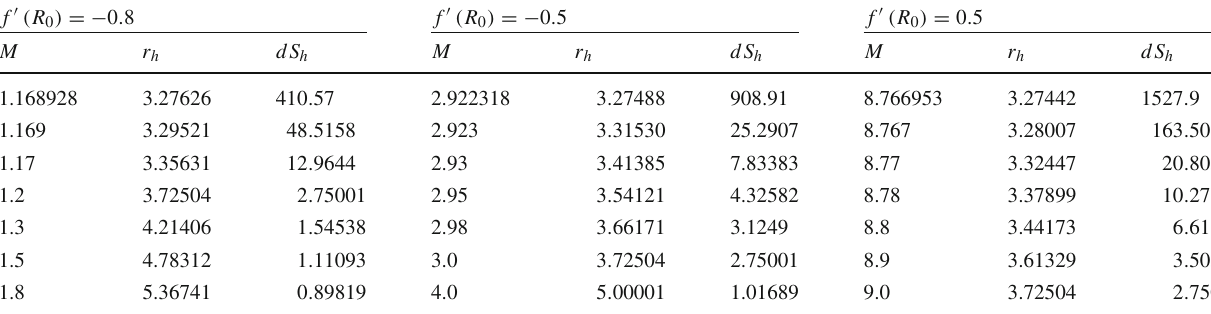
Table 1 The relation between dS h , M and r h of p = 1